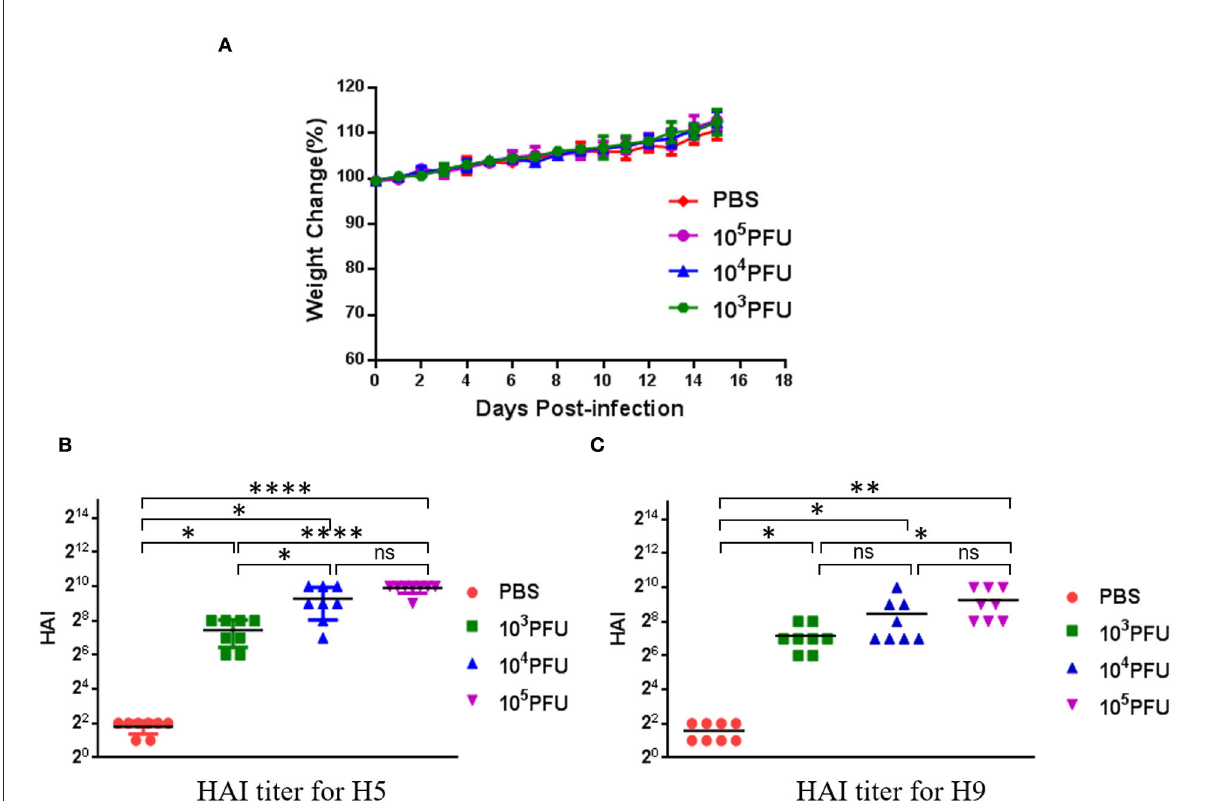
FIGURE6 Evaluation of safety of the recombinant WM01ma-HA (H5) influenza virus as indicated by weight changes of experimental mice (A) and HAI titers against the HN021ma influenza virus (B) and the WM01ma influenza virus (C) . Each symbol represents an individual mouse, and the horizontal lines indicate mean values. The differences between the two groups were analyzed by a one-way ANOVA with Tukey’s multiple-comparison test. ns indicates not significant. ( p > 0.05), *( p ≤ 0.05), **( p ≤ 0.01), ****( p ≤